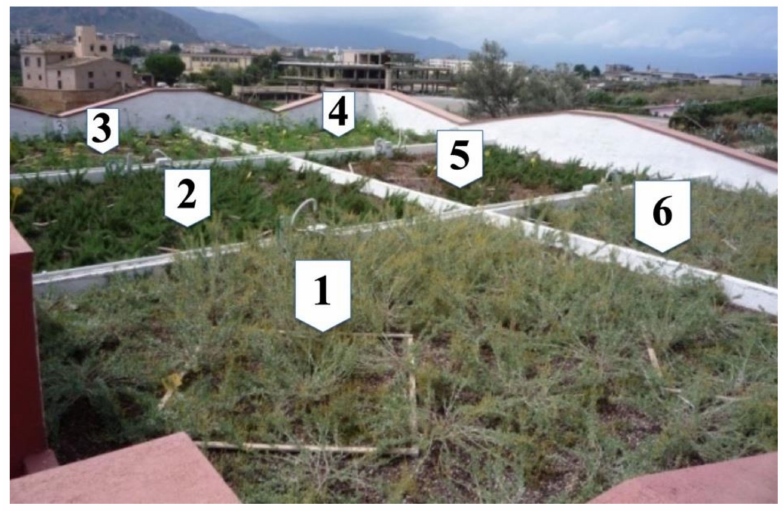
Figure 7. The six-plots green coverages